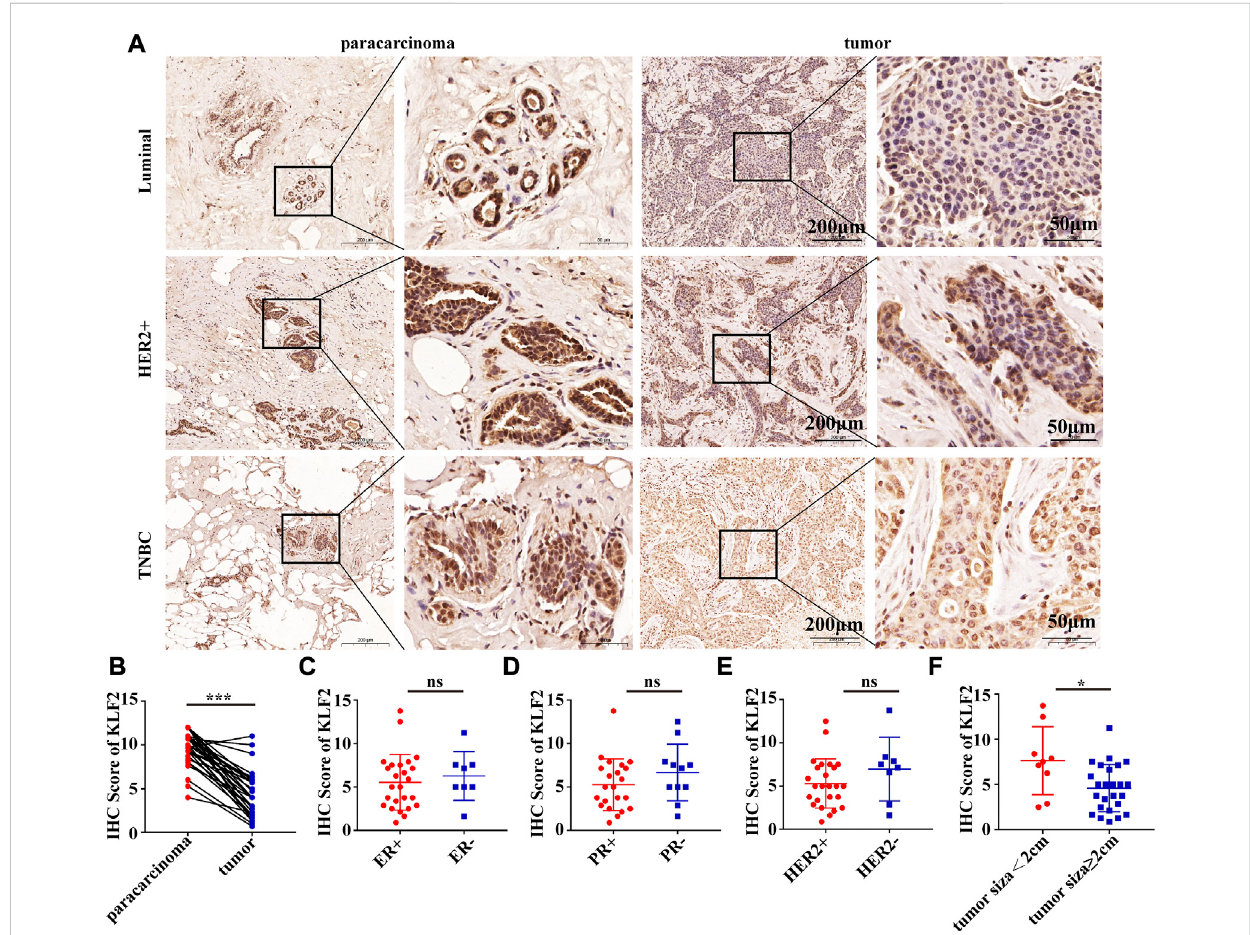
FIGURE 4 KLF2 protein was lower expressed in breast cancer than paracarcinoma tissues. (A, B) Immunohistochemistry was performed to evaluate the expression ofKLF2in paracancerous and breast cancer tissues. Relationship between thelevel ofKLF2expression and ER (C) , PR (D) , HER2 (E) and tumor size (F) . *, p < 0.05; **, p < 0.01; ***, p < 0.001; ns, no signi fi